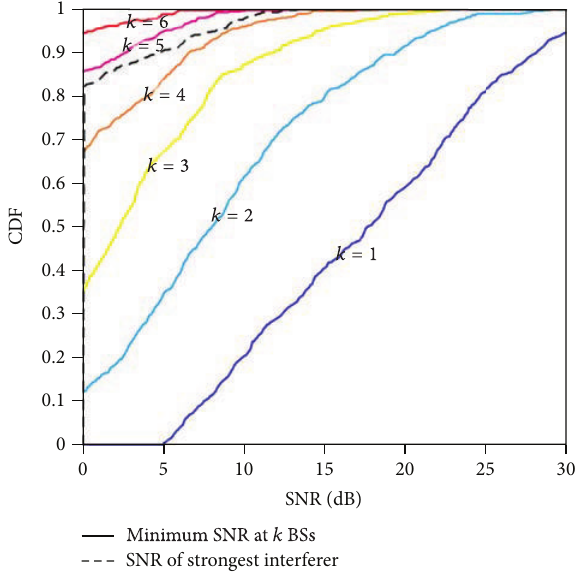
Figure 16: CDF of SNR at the base stations in the CA. The dashed curve shows the CDF of the SNR of the first interferer from outside of the CA. We see that typically 4 base stations in the CA have a higher SNR than the first